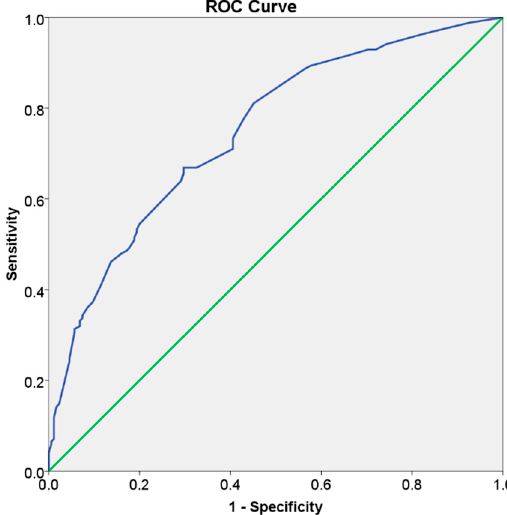
Figure 2. Receiver operating characteristic (ROC) curve illustrating the acceptable discrimination (area under the curve between 0.70 and 0.80) for predicting periodontitis.